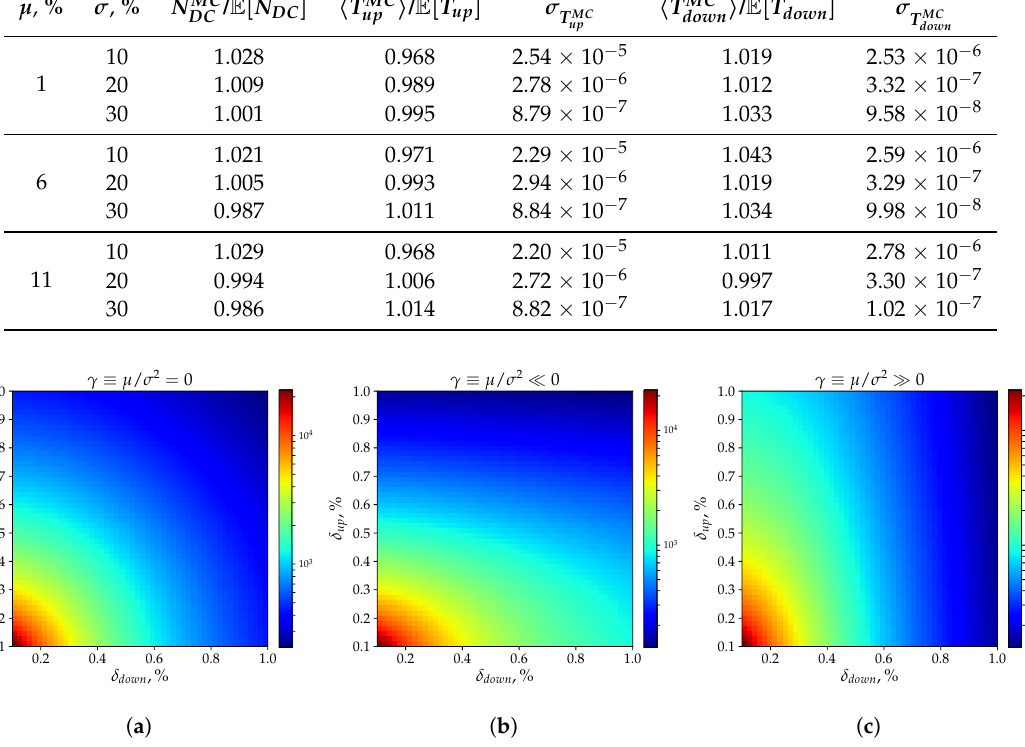
Figure 2. Heatmaps of the number of directional changes observed by the pair of directional-change δ up , δ down thresholds (Y- and X-axis of the plots) in a timeseries of the given length (Geometrical { } Brownian Motion (GBM), 10 9 steps in each simulation). Selected trend and volatility values: ( a ) µ = 0, σ = 0.15; ( b ) µ = 3, σ = 0.15; ( c ) µ = 3, σ = 0.15. The values on the plots coincide with the ones − computed using Equation